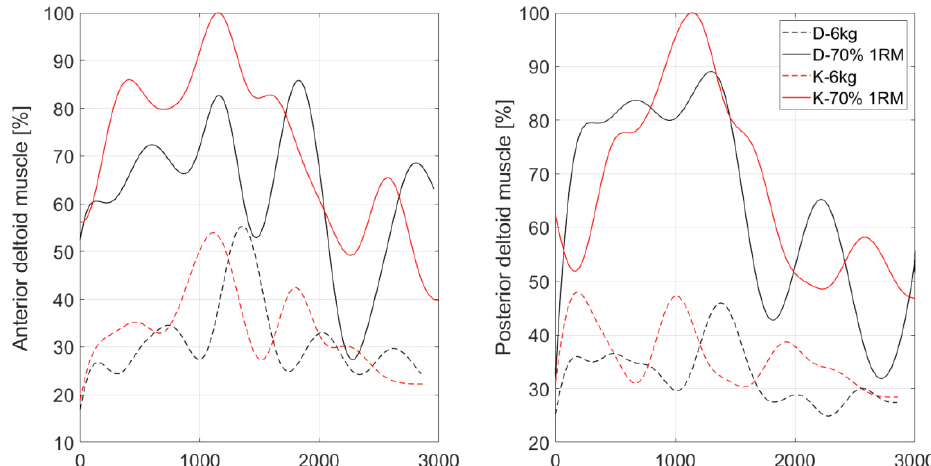
Figure 3. Example waveform of normalized muscle activity for anterior deltoid and posterior deltoid